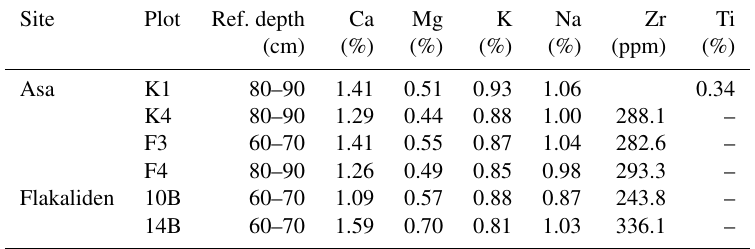
Table 3. Concentrations (weight %, based on geochemical analyses) of different elements at the reference depths used for calculating historical weathering rate at the Asa and Flakaliden